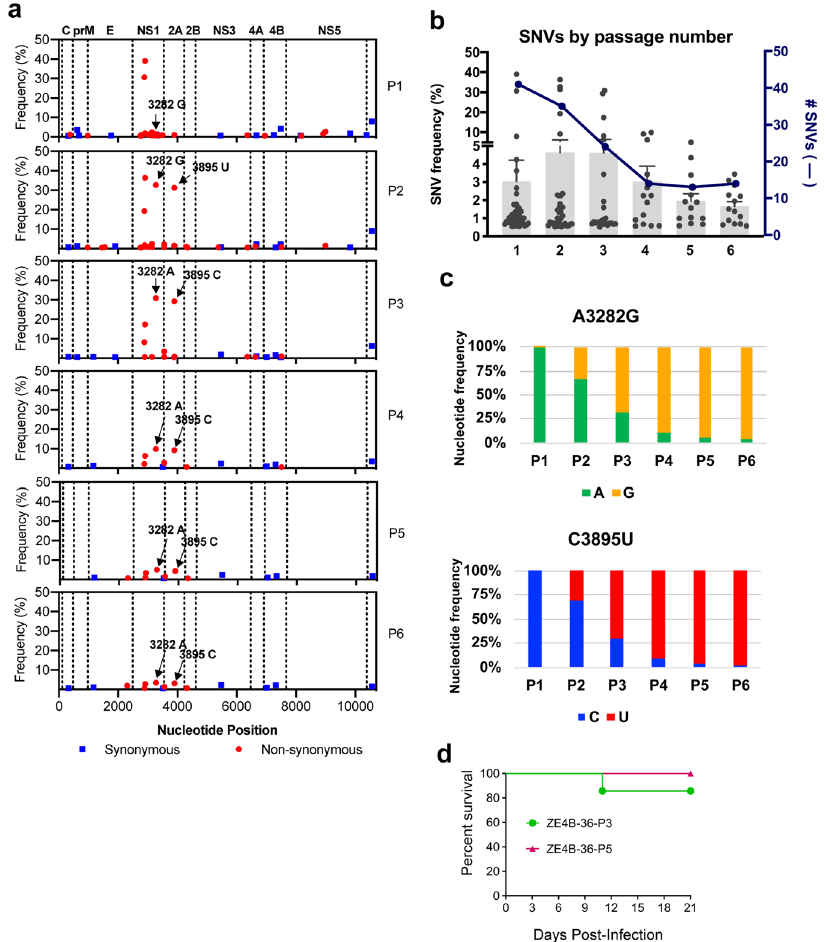
Fig. 2 Genetic stability and neurovirulence studies of in vitro passaged ZE4B-36 mutant. a The genomic sequence of passage viruses was determined using NGS. Consensus sequence and sub-consensus single nucleotide variant (SNV) LofreqV2 analyses were performed for each passage. Results of SNV analysis are presented as the sub-consensus frequency of synonymous (blue squares) and non-synonymous SNVs (red circles) detected relative to position across the genome for P1 – 6. Arrows point to SNVs A3282G and C3895U, which increased to greater than 50% frequency at P3 becoming consensus sequence changes. Following the consensus sequence changes of 3282A to G and 3895C to U, the original nucleotides (SNVs 3282A and 3895C in P3 – P6) continued to decrease in frequency . b Total number (blue line) and mean frequency (black symbols, mean in gray bars) of SNVs identi fi ed in each passage was determined. c The SNVs A3282G and C3895U and contribution of each SNV at each of the two genomic positions is presented as frequency percentage. d Comparison of neurovirulence between P3 and P5 of ZE4B-36 in Swiss Webster mice. One-day-old Swiss Webster mice were infected with 1.5 × 10 4 FFU P3 ( n = 7) and P5 ( n = 10) of ZE4B-36 via intracranial injection. Survival percentages of infected mice are